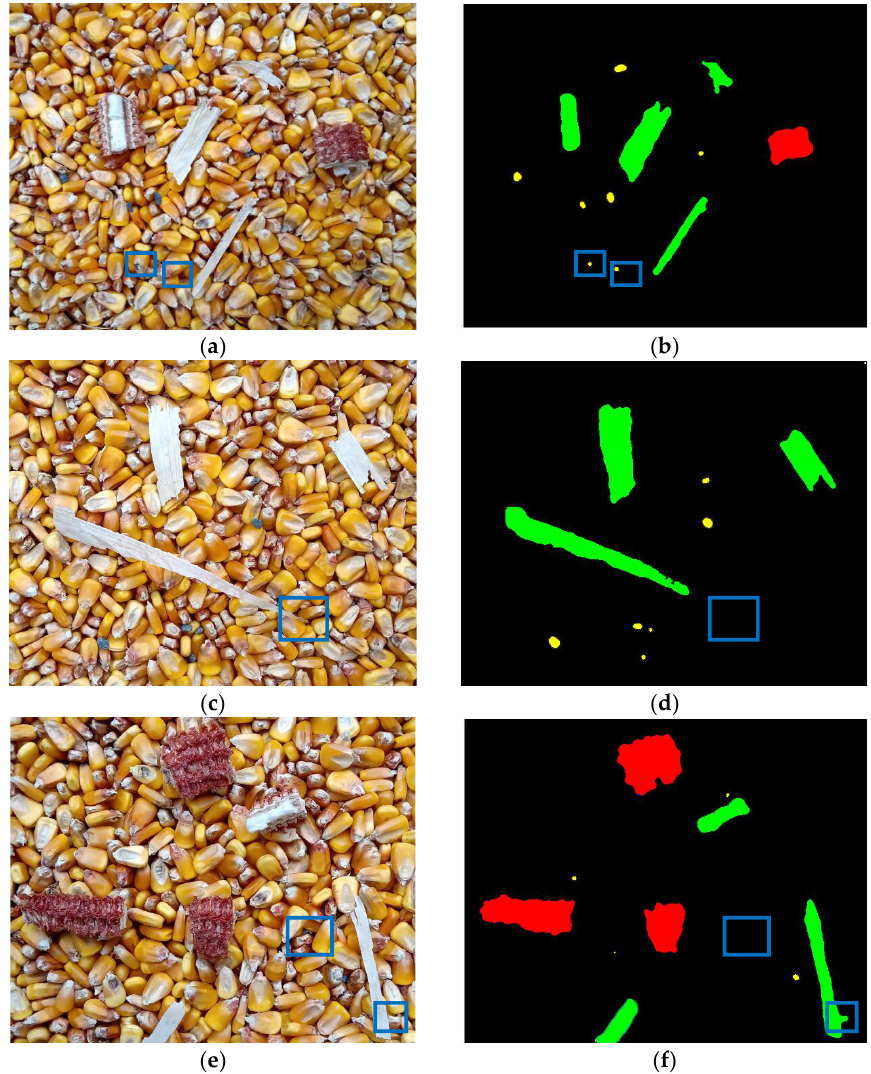
Figure 10. Recognition results of corn images. ( a ) Experimental original image 1, ( b ) Identification result 1, ( c ) Experimental original image 2, ( d ) Identification result 2, ( e ) Experimental original image 3, ( f ) Identification result 3.